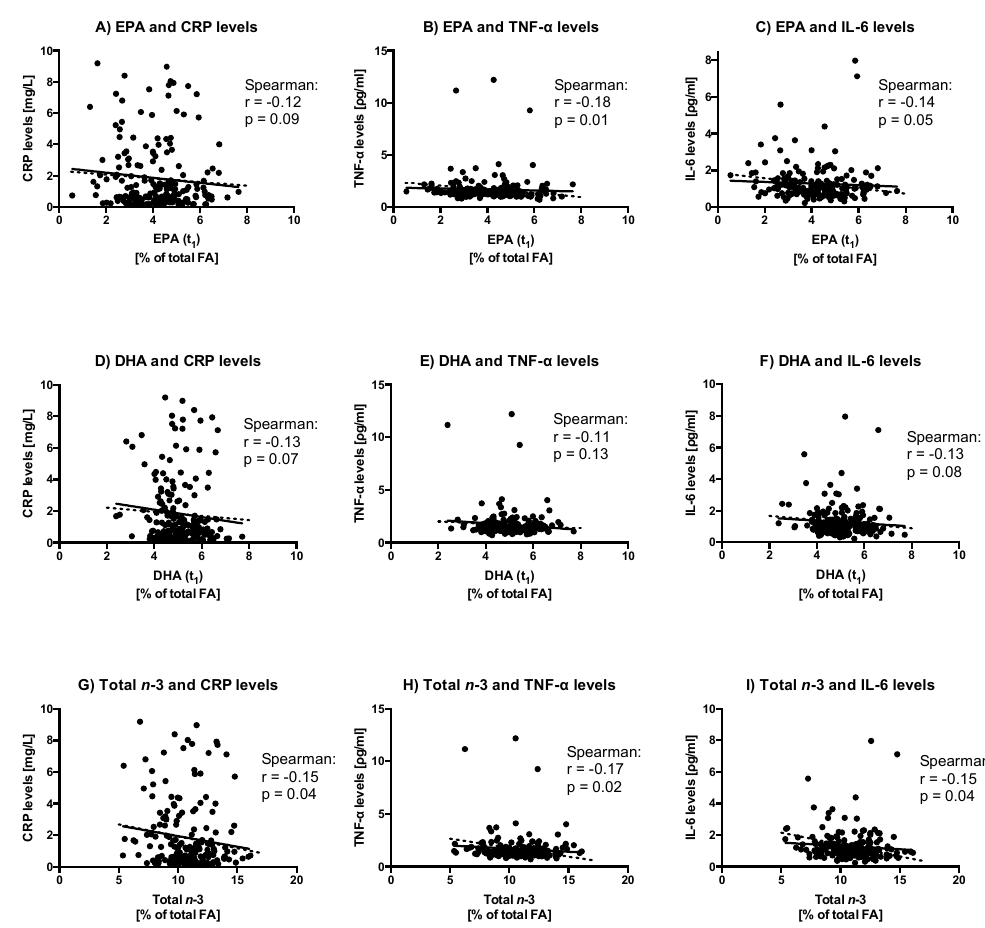
Figure 1. Partial Spearman correlations between EPA, DHA or total n -3 PUFA (in % of total FA) from phospholipids and inflammatory marker levels controlled for baseline data (both FAs and inflammatory marker levels), age, sex and BMI. Panels ( A – C ) show correlations between EPA (in % of total FA) and inflammatory markers; Panels ( D – F ) show correlations between DHA (in % of total FA) and inflammatory markers; and panels ( G – I ) show correlations between total n -3 (in % of total FA) and inflammatory markers; straight lines: unadjusted regression slope, and dotted lines: adjusted regression slope with baseline inflammatory marker levels, baseline n -3 from phospholipids levels, age, sex and BMI ( n = 191).